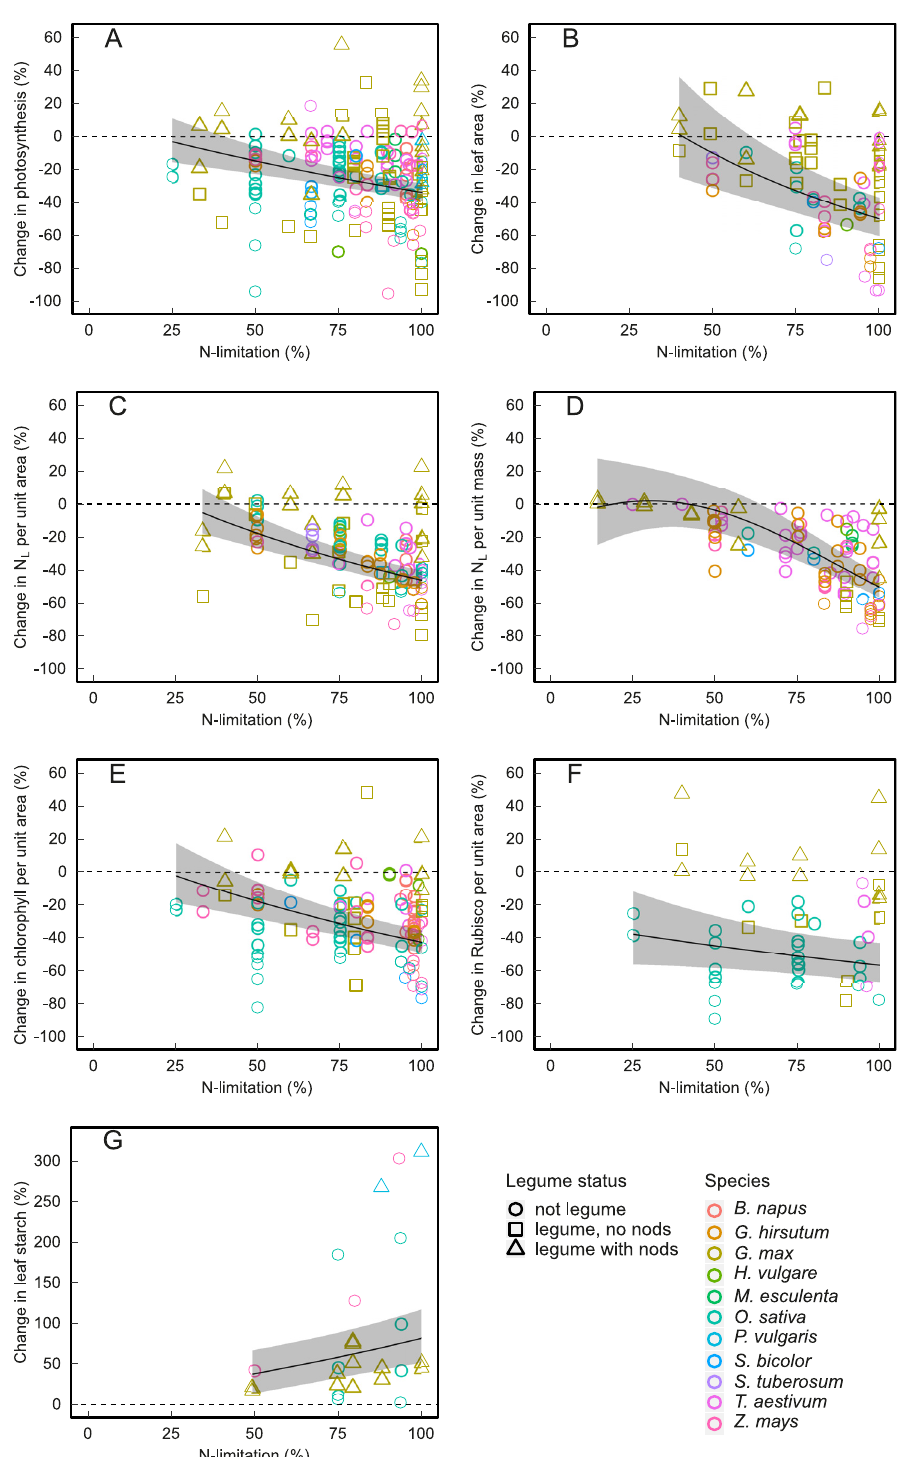
Fig 3. Effect of increasing N limitation on leaf-level variables. Relationship between leaf-level variables and experimental N limitation, where maximum N limitation (i.e., N limitation = 100%) means zero nitrogen addition in the N limitation treatment. Line shows modelled response (linear, except for N L per unit mass, panel d, that also includes a quadratic term) and the shaded area indicates the 95% confidence interval. Each point represents one experiment. The individual panels show (a) photosynthesis (studies = 50, experiments = 182), (b) leaf area (21, 80), (c)